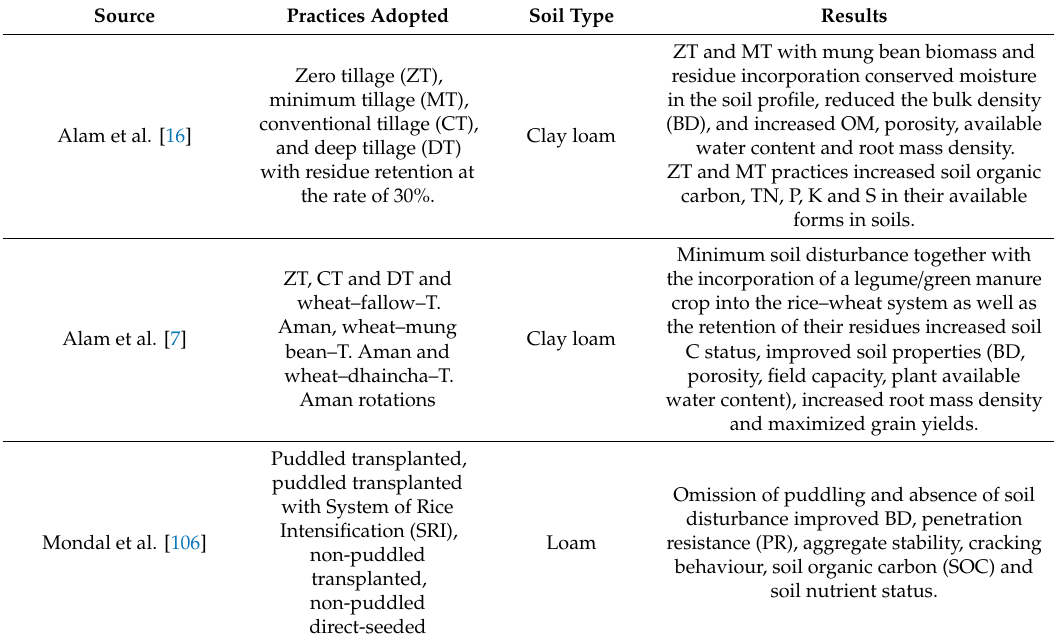
Table 1. E ff ect of rice crop establishment practices on soil